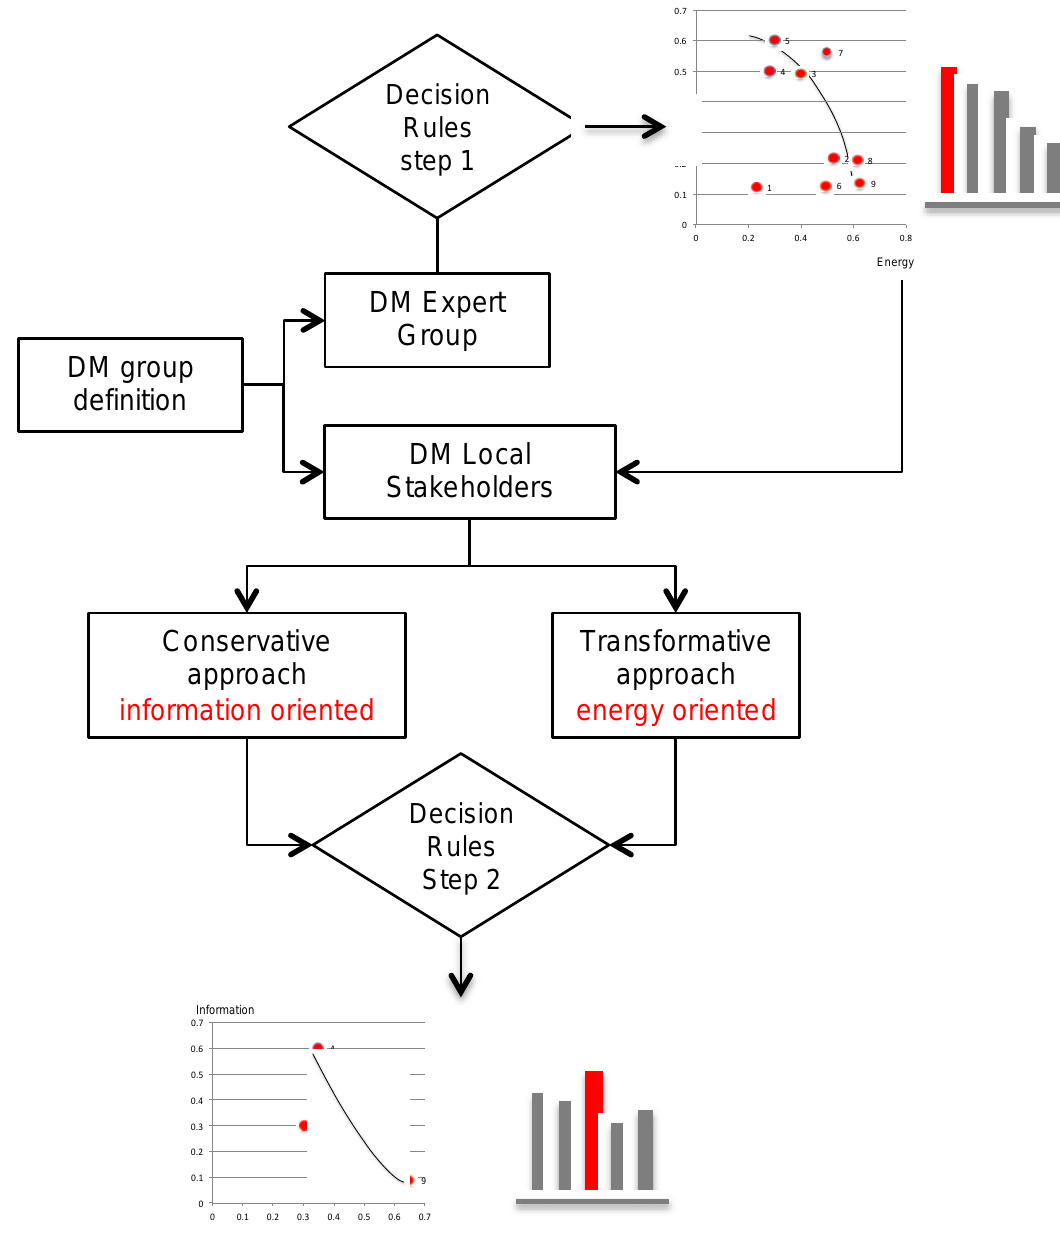
Figure 4. General flow chart of the decision making process.